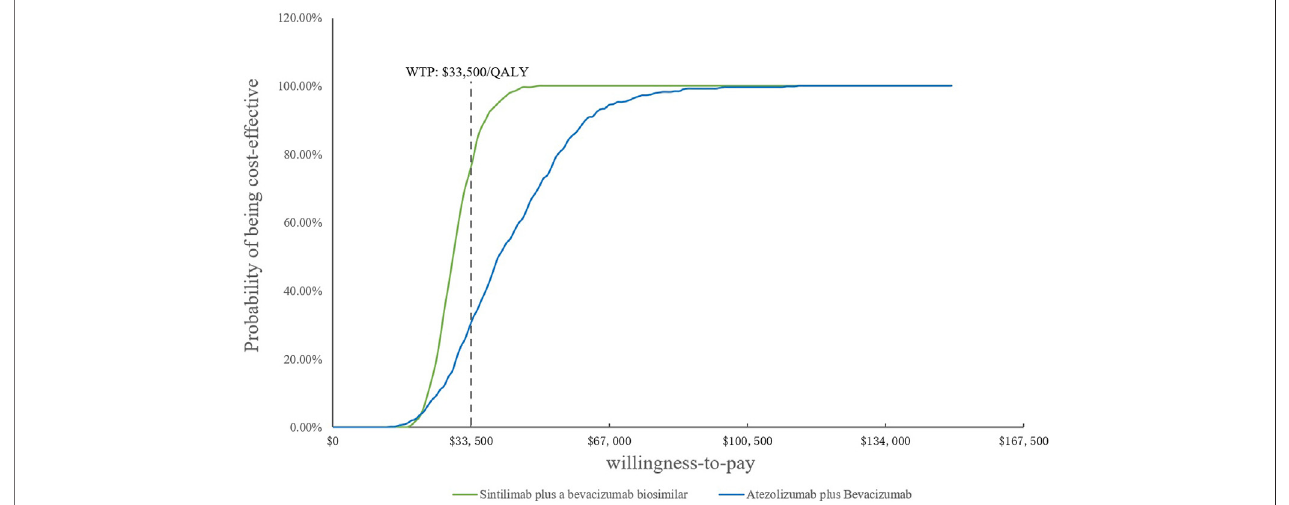
FIGURE 6 | Cost-effectiveness acceptability curves of the scenario analysis. WTP, willingness-to-pay; QALY, quality-adjusted life year.